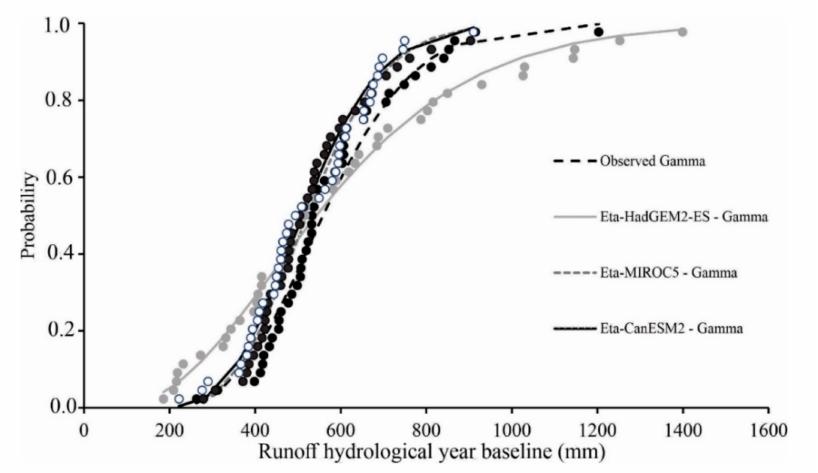
Figure 11. Gamma probability function (GPF) fitted to the observed series and simulated runoff series for the